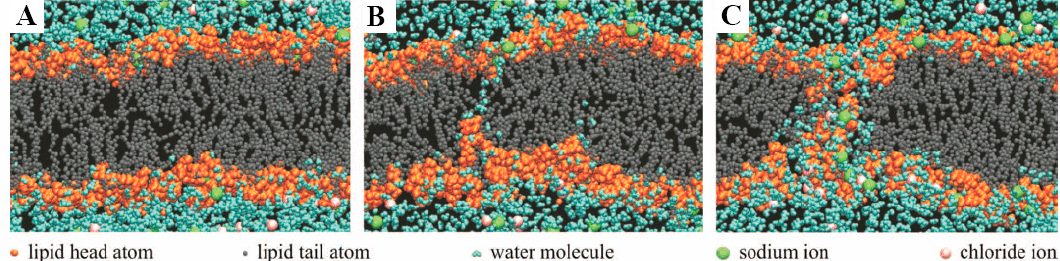
Figure 4. Molecular dynamics showing the progress of an aqueous pore forming within the lipid bilayer during electroporation. From left to right ( A ) the intact bilayer, ( B ) a few water molecules enter the lipid regime, starting to form a “water path”, and ( C ) the neighbouring lipids reorient, stabilizing the “water pore” and allowing the ions to enter. Reprinted with permission from ref. [39] Copyright © 2012, IEEE.